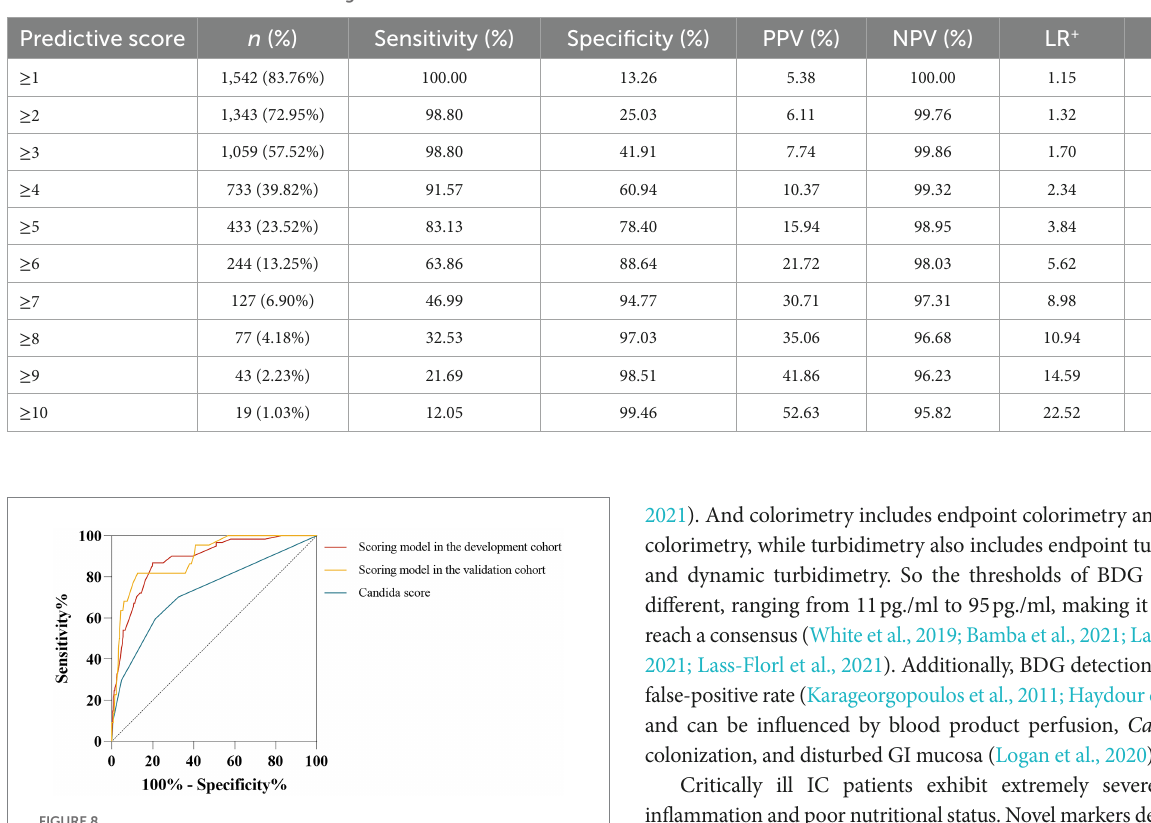
FIGURE 8 Comparison of receiver operating characteristic curves for IC risk between the scoring model and Candida score. The AUC of the scoring model was similar between the development cohort and validation cohort (0.883 vs. 0.892, p = 0.825). AUC of the scoring model was higher than the Candida score (0.883 vs. 0.730,